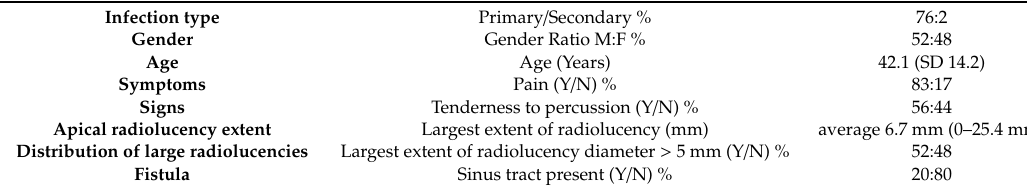
Table 1. Overview of clinical